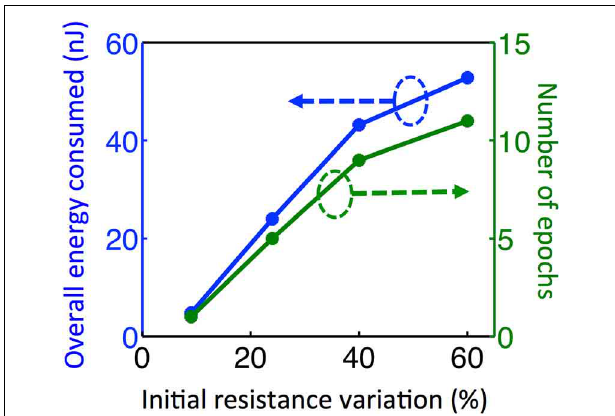
FIGURE 7 | The same experiment is repeated for different initial variation cases. In order to guide the eye, dashed arrows and circles indicate which curves correspond to which axis. For four different initial variation cases, the plot shows the total number of epochs required for training as well as overall energy consumed in the synaptic devices during training and recall phases for pattern 1. As the variation increases, larger firing threshold is required for neurons. This increases the number of epochs and energy consumption required for